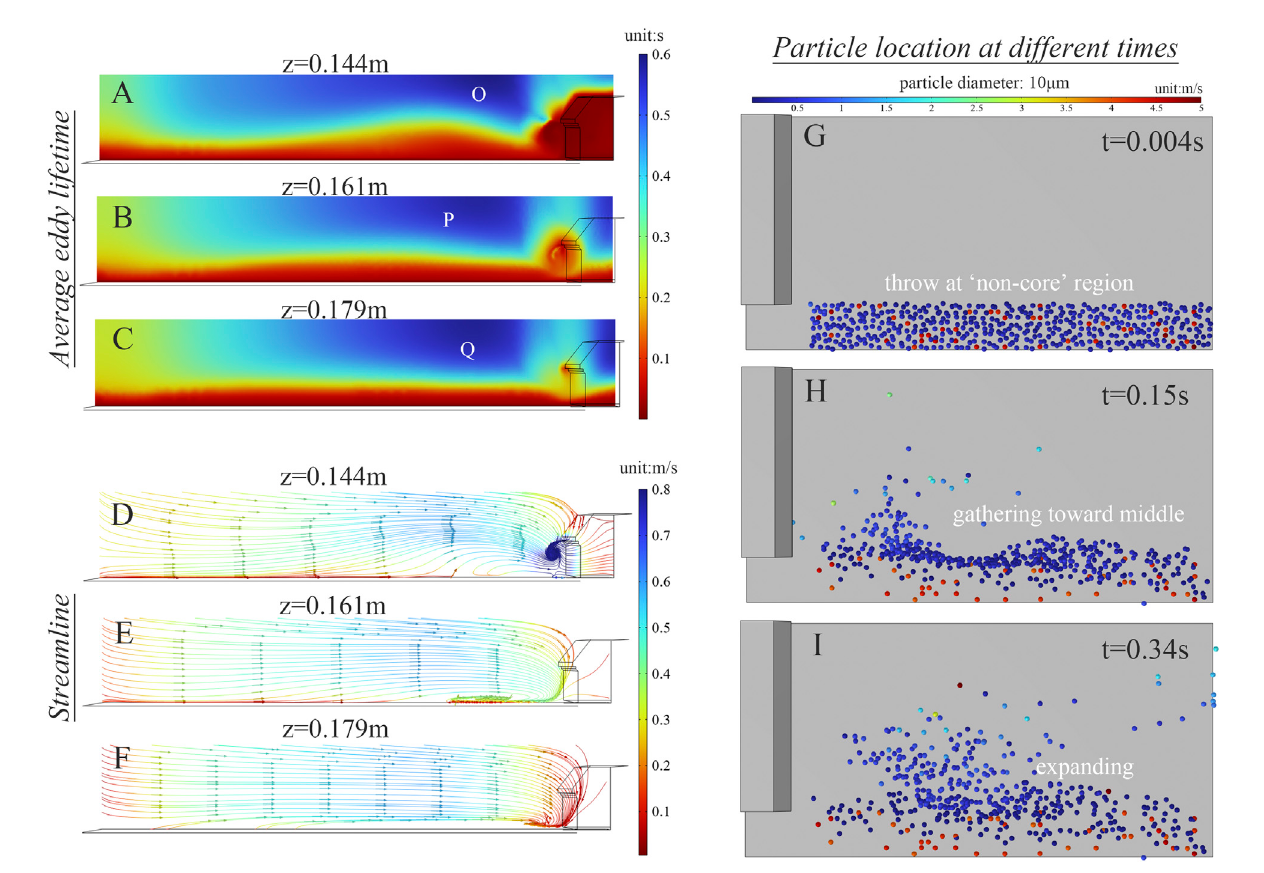
FIGURE 9 Explanationofsedimentationpercentageincreasedinthenon-coreregion,where (A – C) istheaverageeddylifetimeoftheprotection fl owtransectedat 0.144, 0.161, and 0.179 m, respectively, while (D – F) is the streamline distribution transected at the same location, respectively; (G – I) are particle trajectories simulated at different times after releasing at the top of the non-core